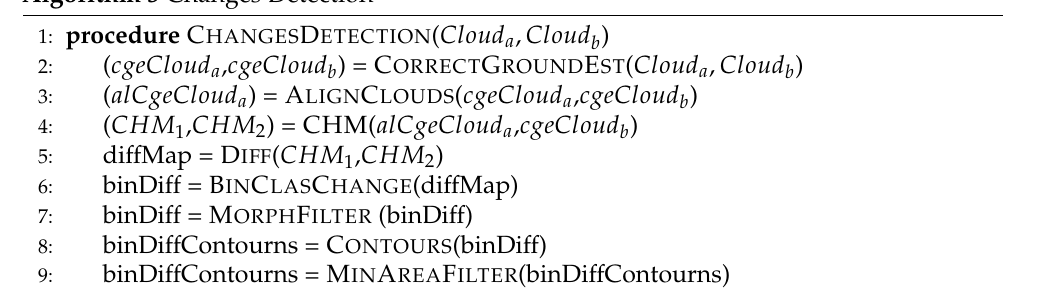
Algorithm 3 Changes